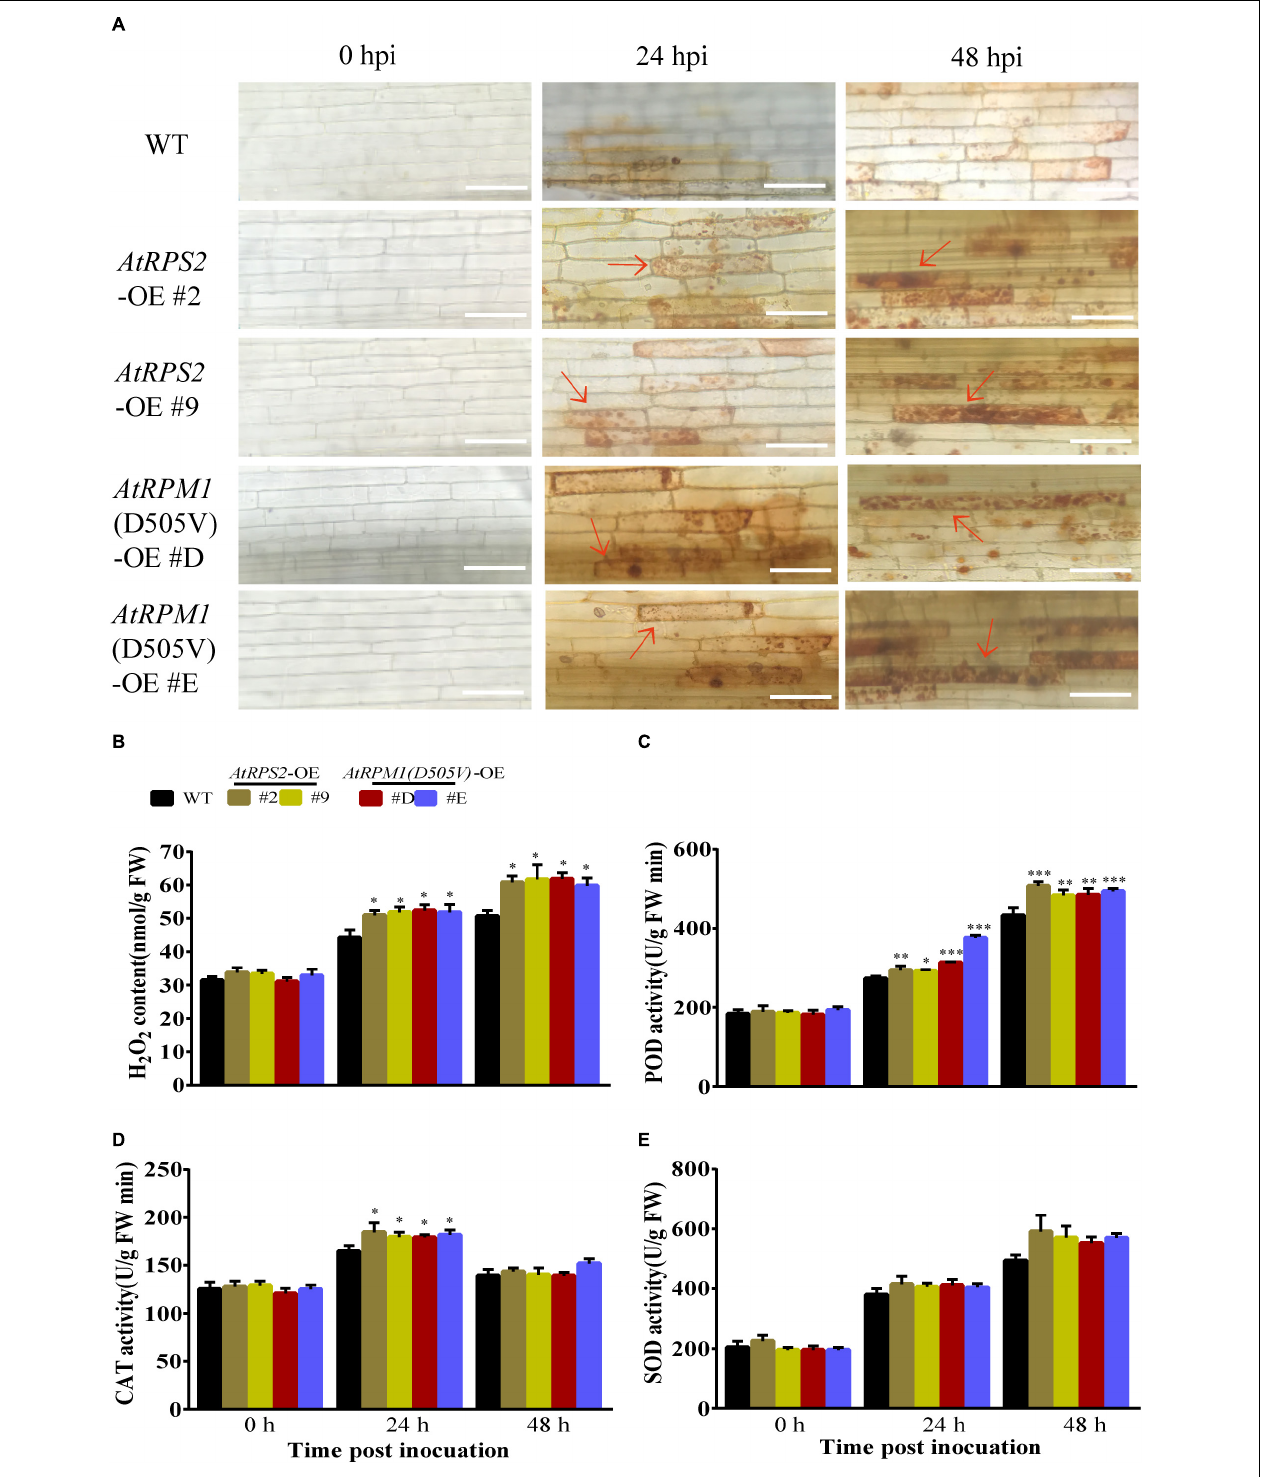
FIGURE 4 | AtRPS2 and AtRPM1 ( D505V ) Trigger Strong ROS Induction During M. oryzae Infection. (A) DAB staining of the transgenic plants and Nipponbare at 24 and 48 hpi. There were many tawny shading cells in the transgenic plants, but in Nipponbare, the infected cells mostly exhibited light yellow color. Red arrows indicate dead plant cells. Scale bars = 50 µ m. (B) H 2 O 2 contents after inoculation with M. oryzae isolate GC1-4 in Nipponbare and transgenic plants. FW, fresh weight. (C–E) The enzymatic activities of POD, CAT, and SOD were assayed after M. oryzae inoculation. Data are shown as means ± SD ( n = 3). Asterisks denote significant differences (one way ANOVA, ∗ P < 0.05, ∗∗ P < 0.01, ∗∗∗ P < 0.001). Similar results were obtained in three independent experiments.